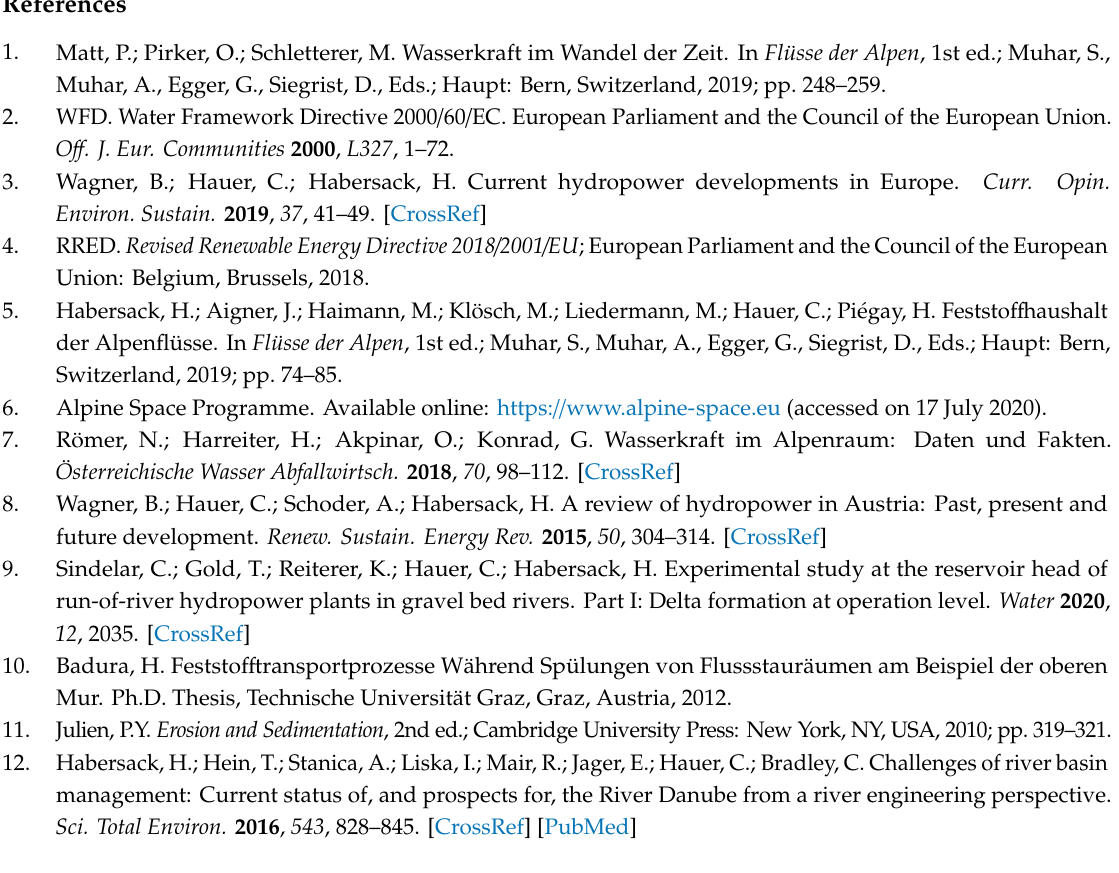
drawdown flushing. drawdown